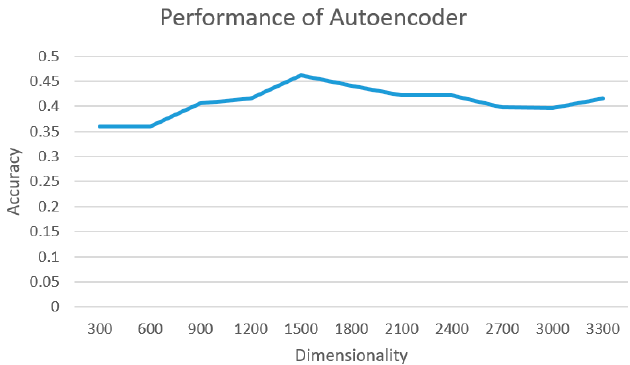
Figure 11. The performance of autoencoders with different dimensionality.